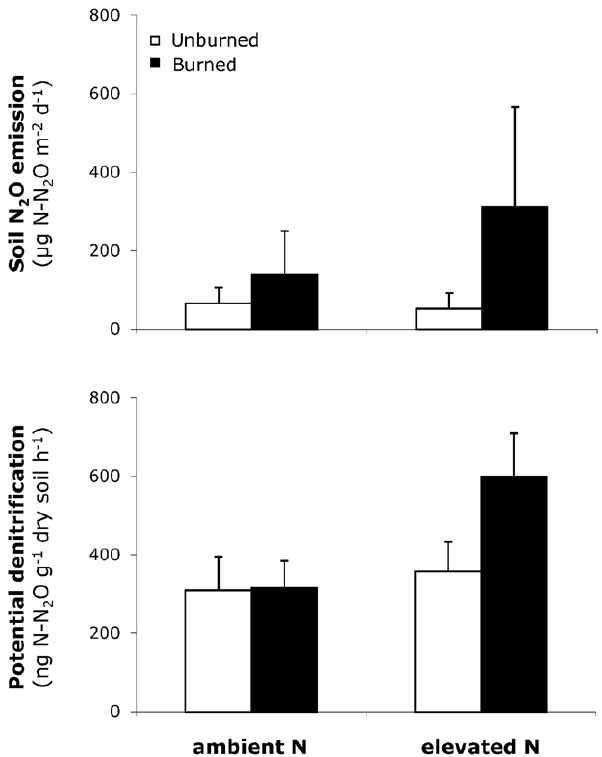
Figure 4. Effects of fire on soil N 2 O emission and potential denitrification rates under ambient and elevated nitrogen supply. The top section shows the effects of burn and N on soil N 2 O emission rates, and the bottom section shows the effects of burn and N on potential denitrification rates. The data of soil N 2 O emission and potential denitrification rates are grouped by burn treatment (unburned: open bars, burned: closed bars) and by N treatment (ambient vs. elevated). Each bar is the average of data collected 15, 19, 21, and 33 months after fire. Error bars denote pooled standard error (for each N treatment, n=24 6 4 sampling dates for unburned plots; n=16 6 4 sampling dates for burned plots).